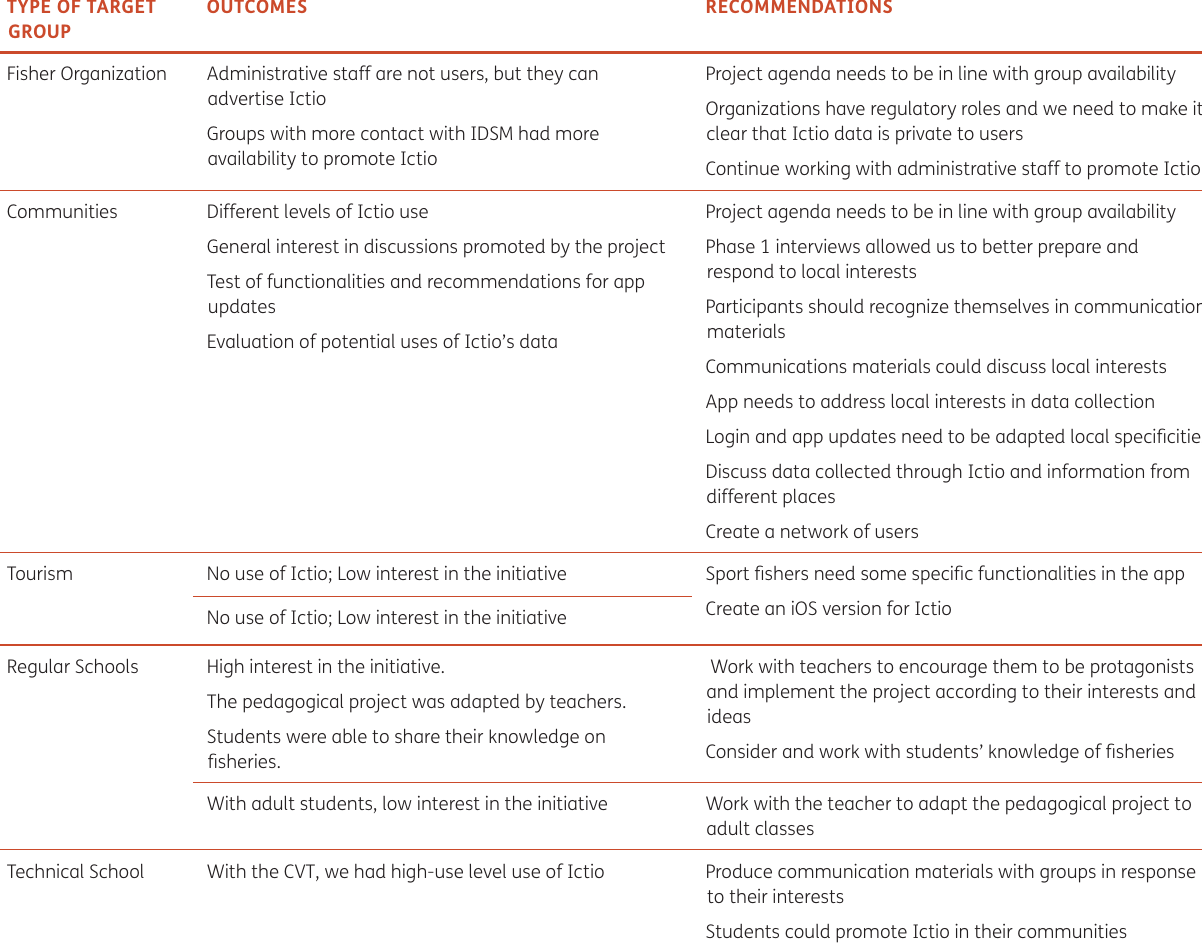
Table 2 Outcomes and recommendations organized by target